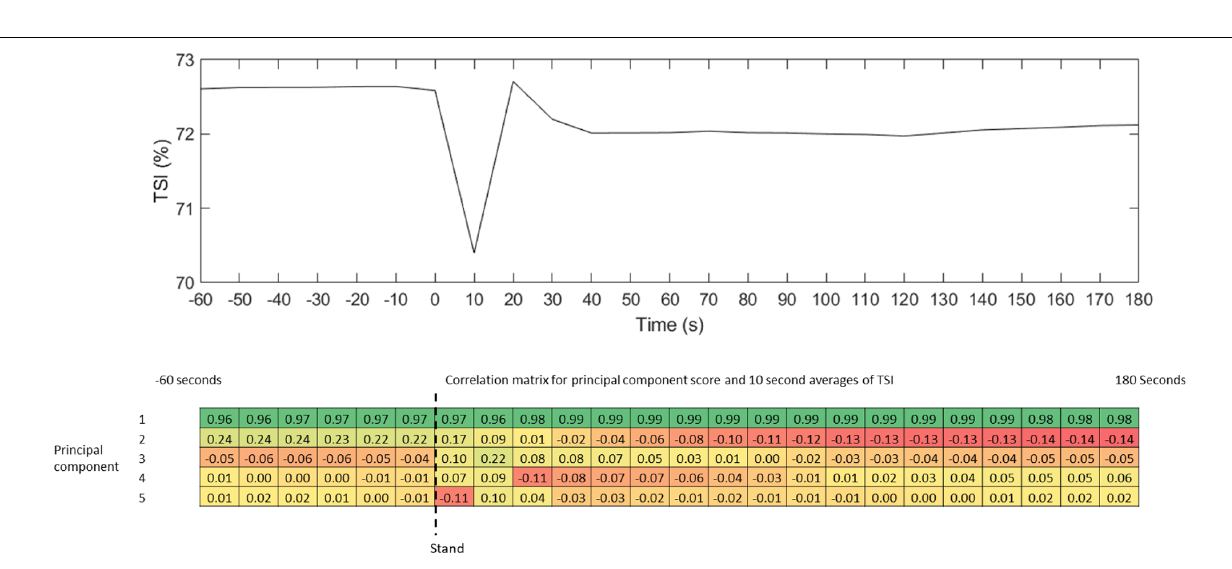
FIGURE 2 | Correlation between 10-s averages of original tissue saturation index (TSI) data and principal component